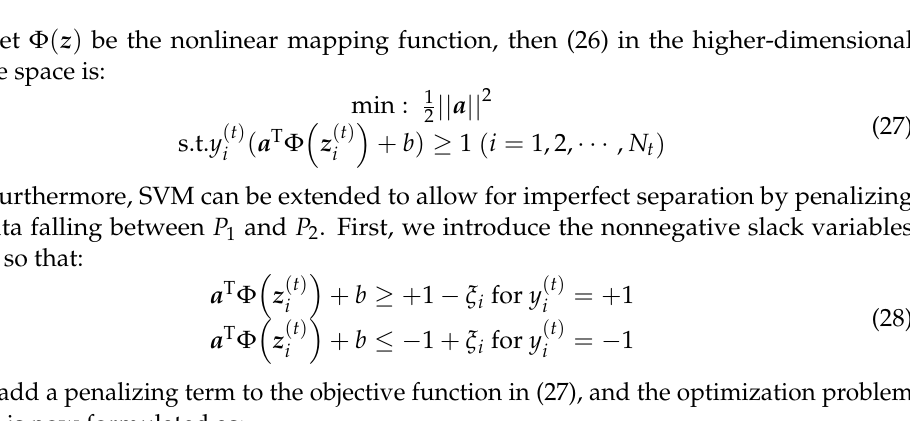
Figure 6. A nonlinear separating region transformed into a linear one.